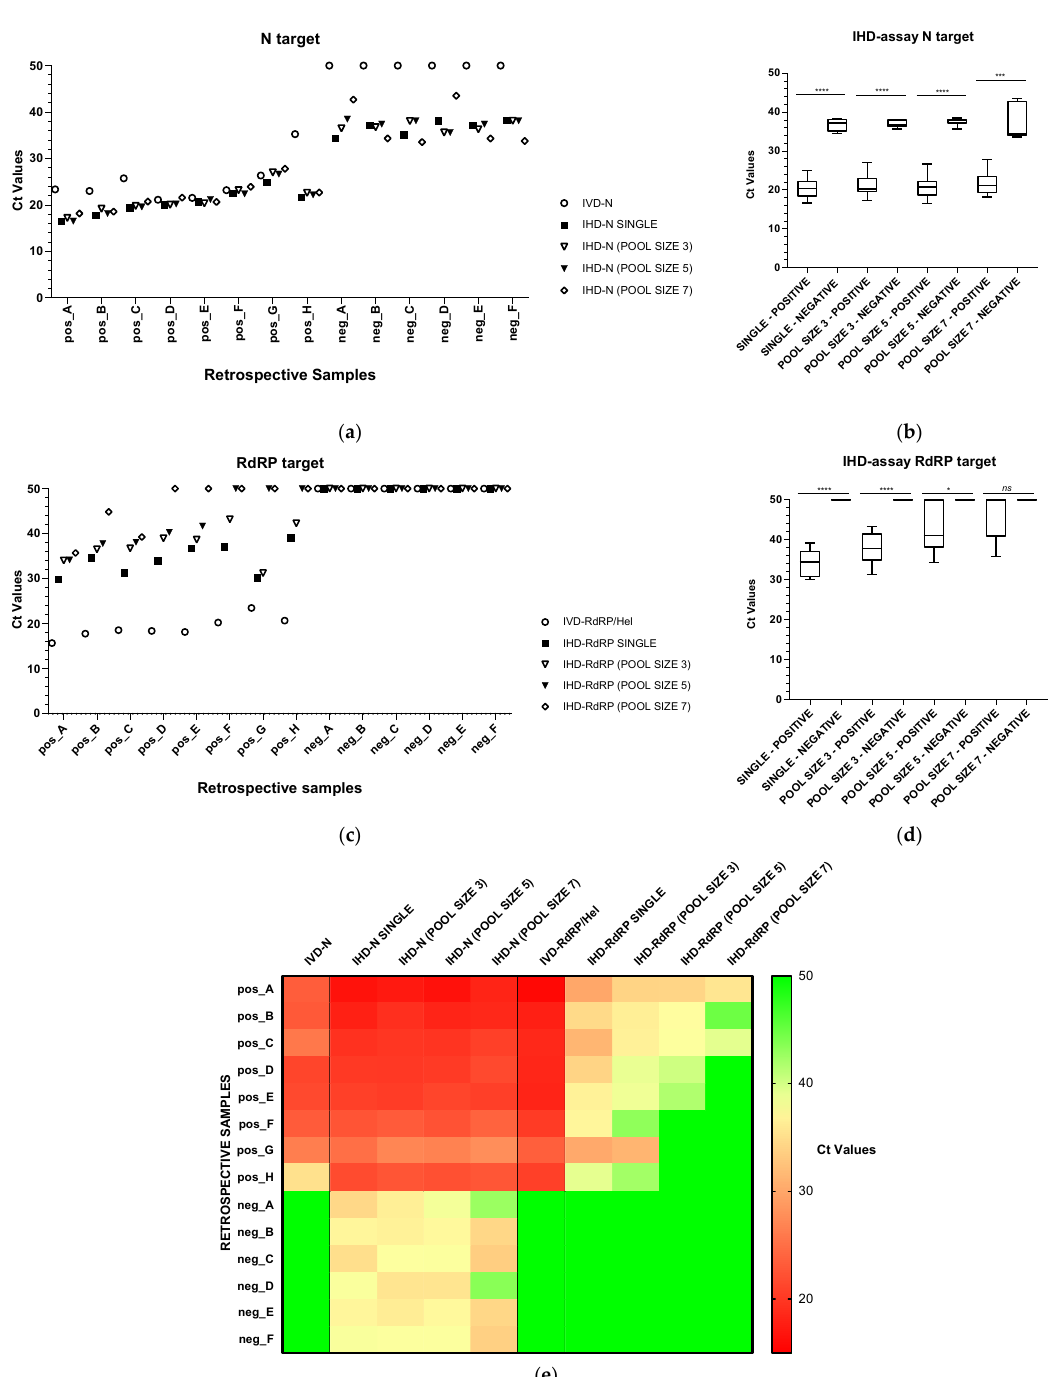
Figure 2. SARS- CoV-2 detection by multiplex RT-qPCR on pooled retrospective samples. Eight retrospective positive samples with high and low Ct values in N and in RdRP were grouped with six different negative samples in pool size of 3, 5 and 7. ( a ) Scatter plot representing Ct values recorded by using IVD or IHD assays targeting N gene on single samples or pooled samples. ( b ) Box and whiskers plot representing Ct differences for N target between positive and negative pools of different sizes. ( c ) Scatter plot representing Ct values recorded by using IVD or IHD assays targeting the RdRP gene on single samples or pooled samples. ( d ) Box and whiskers plot representing Ct dispersion differences for RdRP target between positive and negative pools of different sizes. ( e ) Heat map comparing Ct values for target genes N and RdRp recorded for eight positive and six negative retrospective samples through IVD-assay, or IHD-assay run as single sample or as pools of 3, 5 or 7. Statistical significance of Ct value differences between negative and positive samples or pools was measured with unpaired Welch’s t tests (****: p value < 0.0001; ***: p value = 0.0001; * p value < 0.02; ns: not